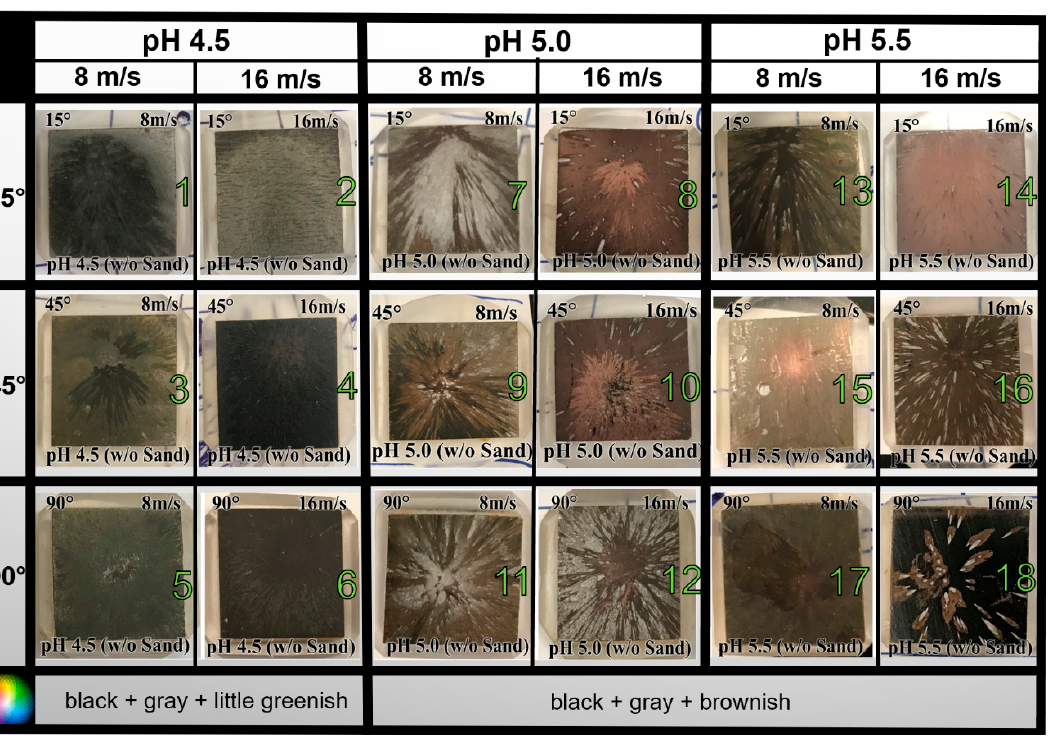
Figure 4. Pictures of API 5L X65 specimens after testing in CO 2 erosion–corrosion (EC) with sand at three pH levels (4.5, 5.0, 5.5), three angles (15°, 45°, 90°), two velocities (8, 16 m/s), and at room temperature.